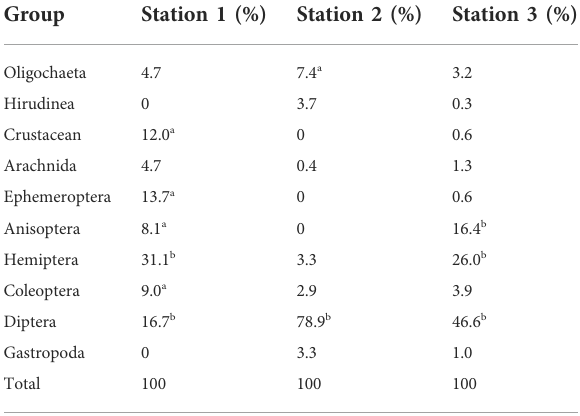
TABLE 3 Distribution of dominant and subdominant benthic groups.